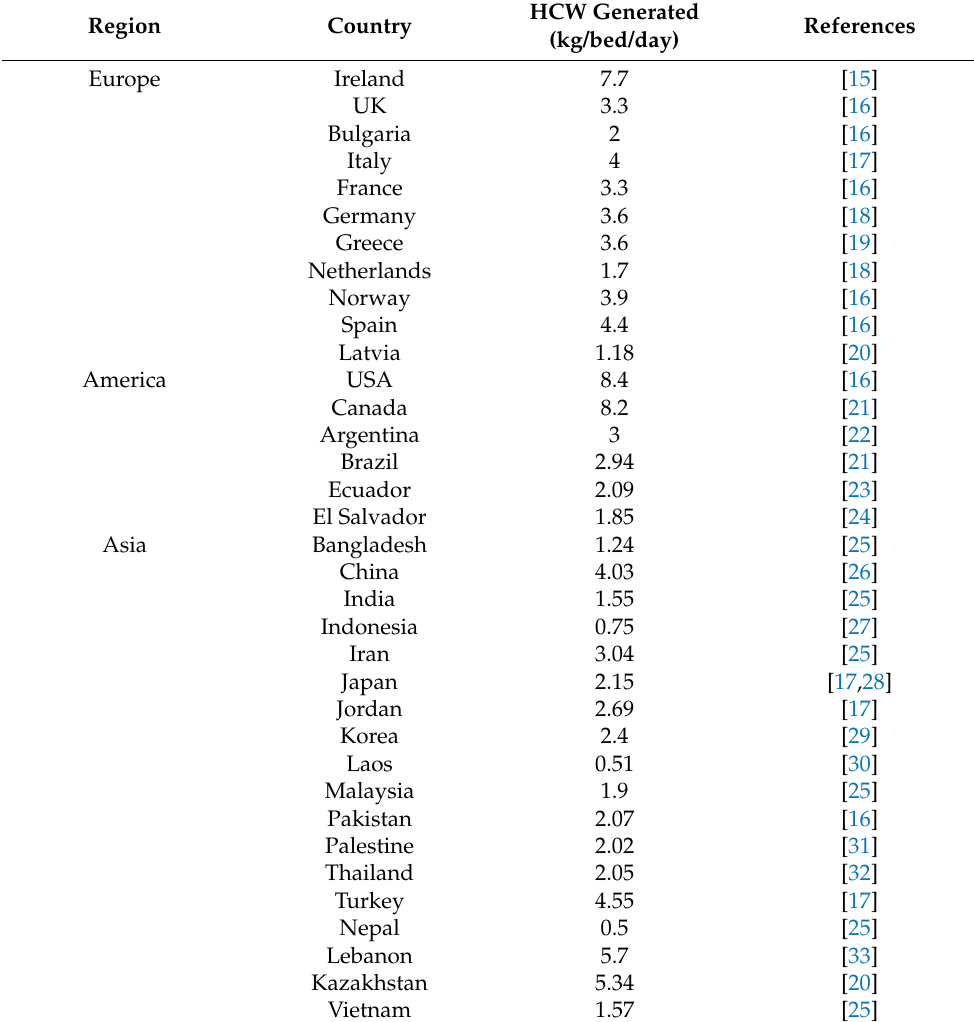
Table 1. HCW generated (kg/bed/day) per country.